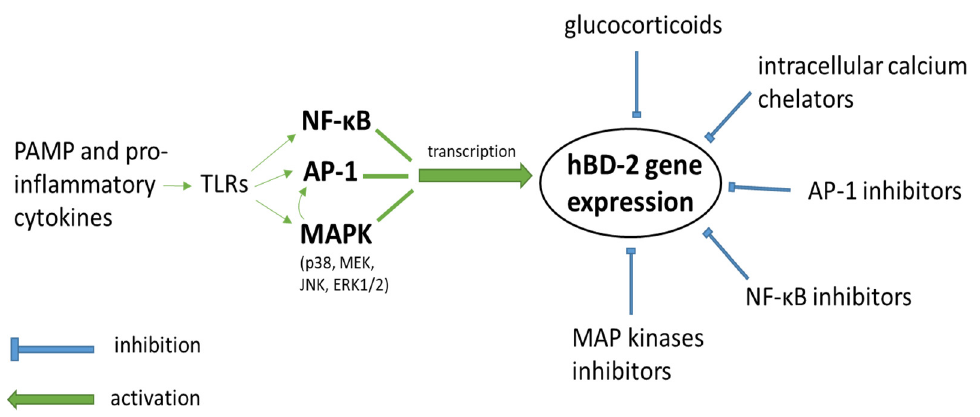
Figure 1. The most frequently described pathways of activation and inhibition of hBD-2 gene ex-